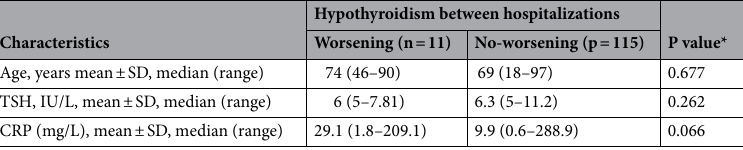
Table 5. Worsening hypothyroidism between hospitalizations and clinical factors in the first hospitalization. Wilcoxon sum rank test. CRP C-reactive protein. *Wilcoxon sum rank test